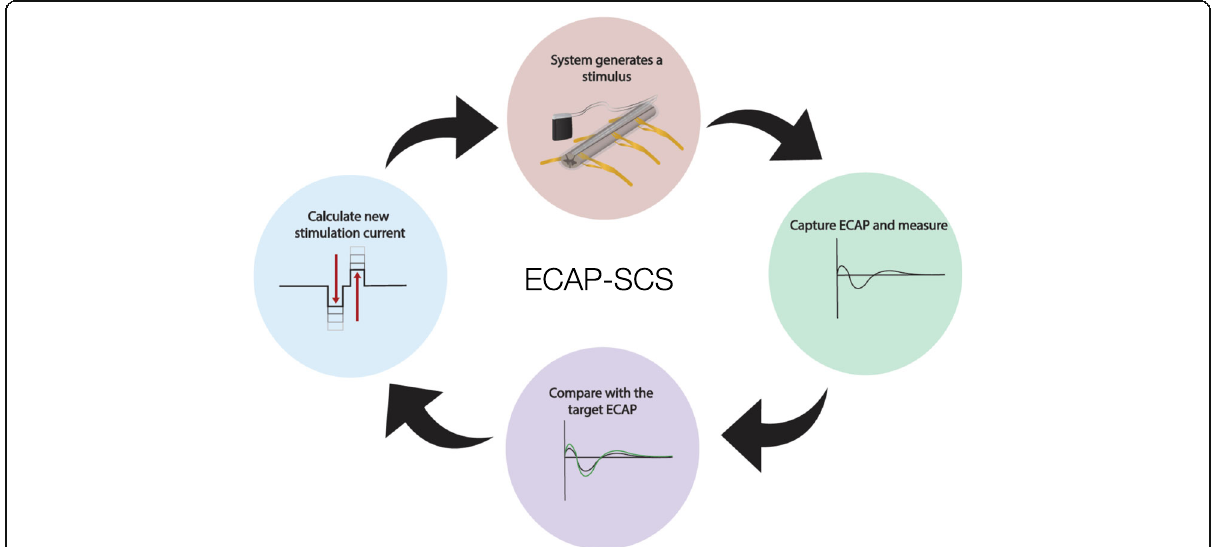
Fig. 11 ECAP-SCS. Newly developed closed-loop SCS system measures evoked compound action potentials (ECAPs) from the spinal cord after each pulse. Greater ECAP amplitude represents more action potentials and is equivalent to increased fiber activation. Variable lead to cord contact occurs with change in position and over time. ECAP-SCS captures and calibrates SCS lead current to target desired ECAP waveform therefore minimizing variability in stimulation, which may improve clinical outcomes. ECAP-SCS is an objective measure of spinal cord activation that may help to predict responders to